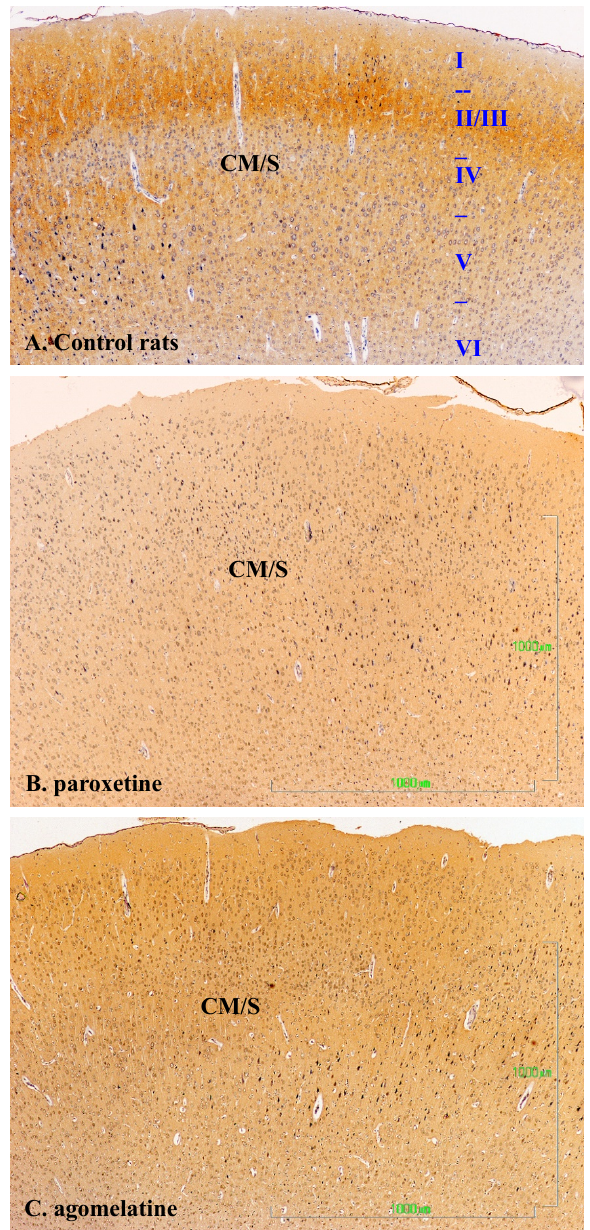
Figure 4. ( A – C ). Tyrosine hydroxylase immunoreactivity in the cerebral cortex layers I-VI of rats from the control ( A ), paroxetine ( B ), and agomelatine ( C ) groups. Bars, 1000 m. (Figure 4A is presented